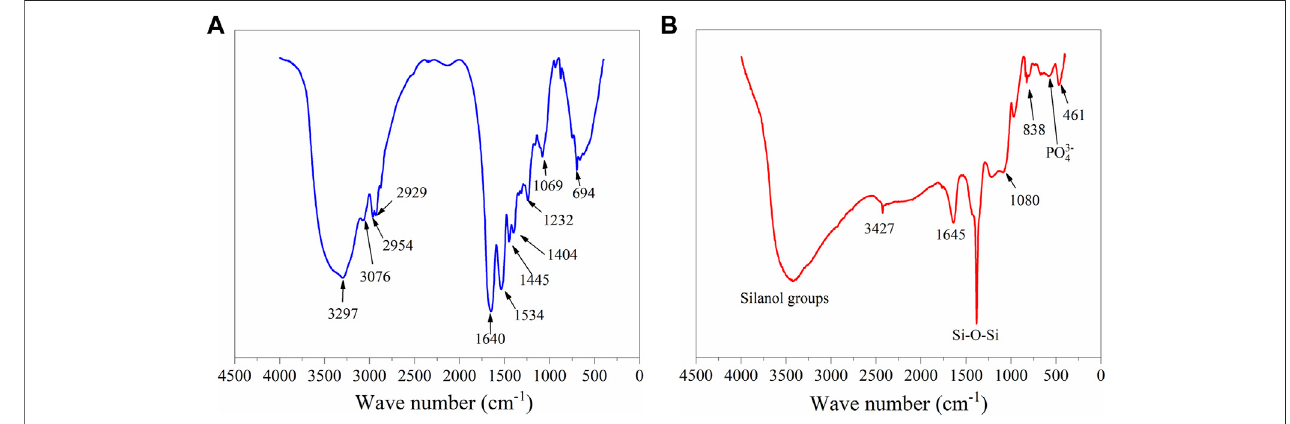
FIGURE 2 | FTIR spectroscopies of the samples ESM (A) and BG (B) .